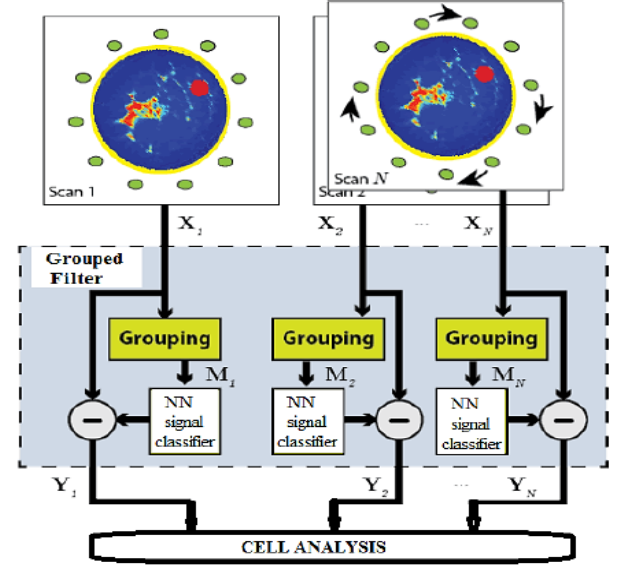
Figure 16. Proposed SCNN technique block diagram